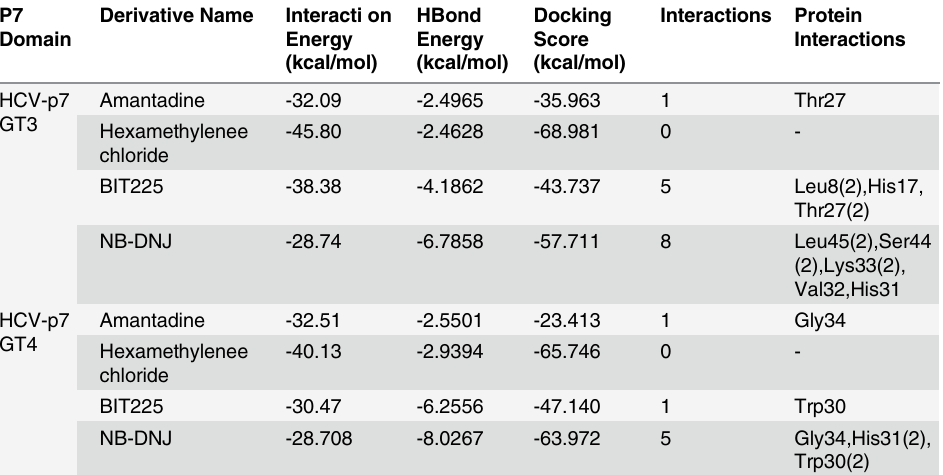
Table 7. Molecular docking study between selected drugs along with both model of p7 GT3 and p7 GT4 and their intermolecular docking values presented with their interaction energy, HBond energy, docking score, number of interactions and the interacting residues.